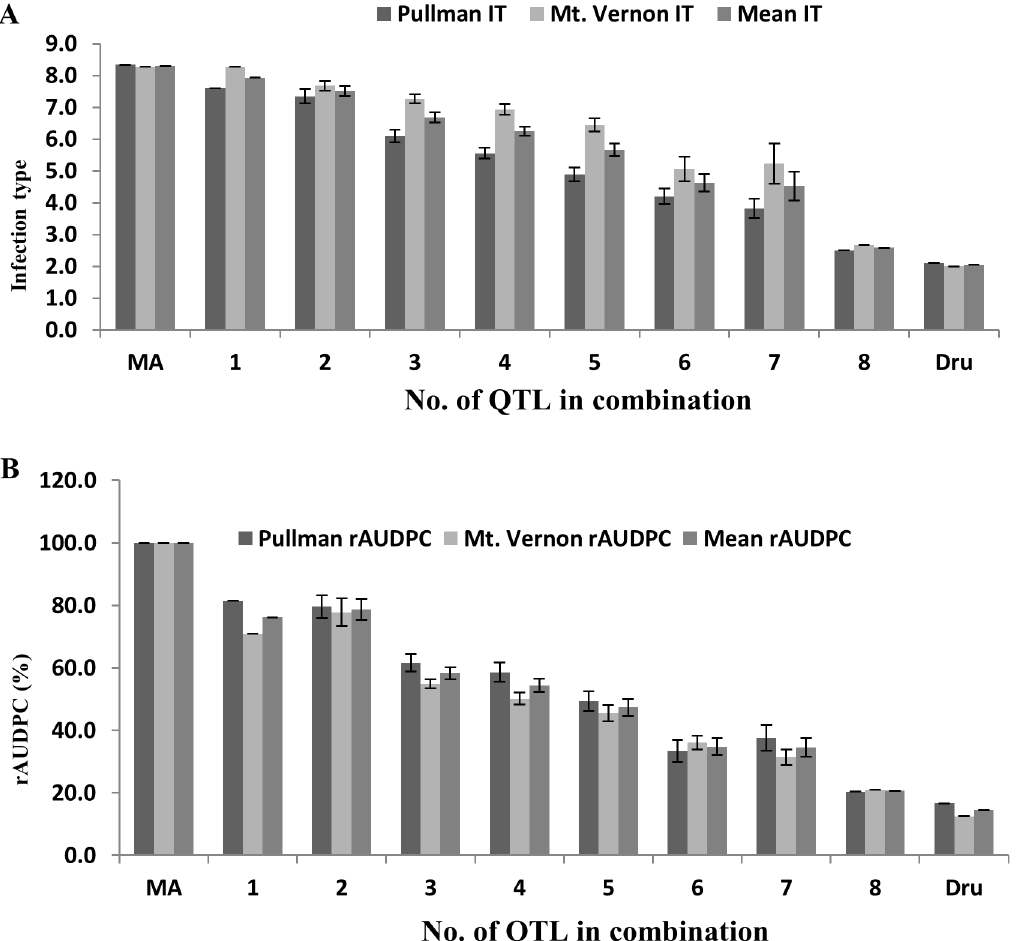
Fig 5. Effects of the number of QTL on high-temperature and adult-plant (HTAP) resistance to stripe rust illustrated by the mean infection type (IT) and relative area under the progress curve (rAUDPC) values of the recombinant inbred lines (RILs) derived from the Druchamp (Dru) × Michigan Amber (MA) in Pullman and Mt. Vernon, showing RILs with more QTL were more resistant. The data of IT are shown in (A) and those of rAUDPC in (B). MA (the susceptible parent does not have any stripe rust resistance QTL and Dru (the resistant parent) has eight QTL for HTAP